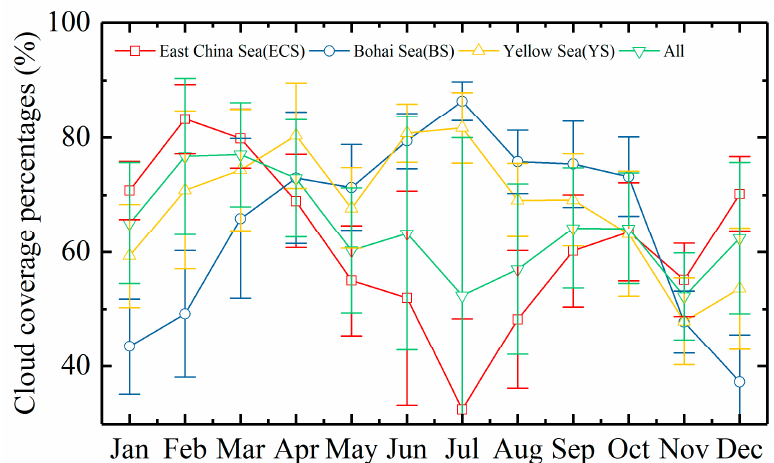
Figure 3. Cloud coverage percentages by month for China’s seas from GOCI observations between 2013 and 2017.